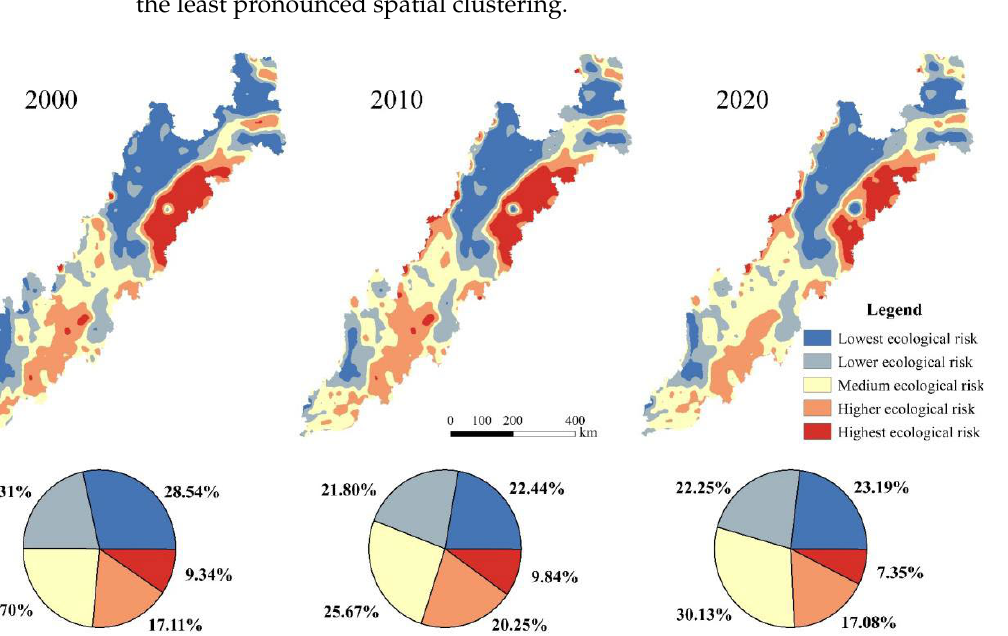
Figure 4. Spatial distribution ( a ) and proportion ( b ) of ecological risk under three different scenarios in 2030. 3.3. Spatial Auto-Correlation Analysis of Landscape Ecological Risk The Moran’s I index of LER in 2000, 2010, 2020, and 2030 in the Sichuan-Yunnan eco- logical barrier area were 0.685, 0.656, 0.625, 0.616, 0.619, and 0.628, respectively. They were